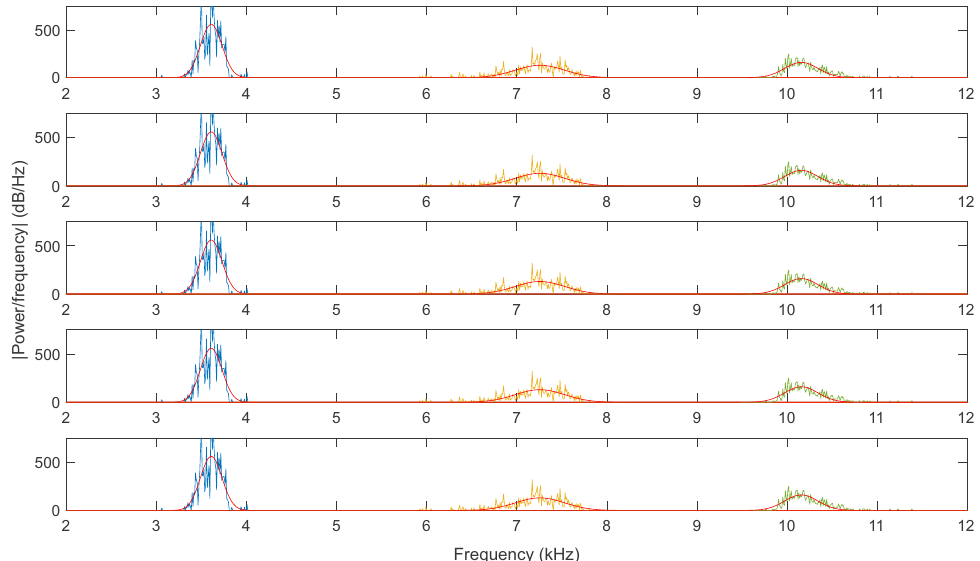
Figure 9. Gaussian approximation method. Each subplot shows the result of the application of the three bandpass filters to an audio set obtained as illustrated in Figure 5, for the case of Figure 3a. The blue, yellow, and green lines correspond to the readings for the fundamental, first, and second harmonic frequencies, respectively. The red line corresponds to the Gaussian estimation of such